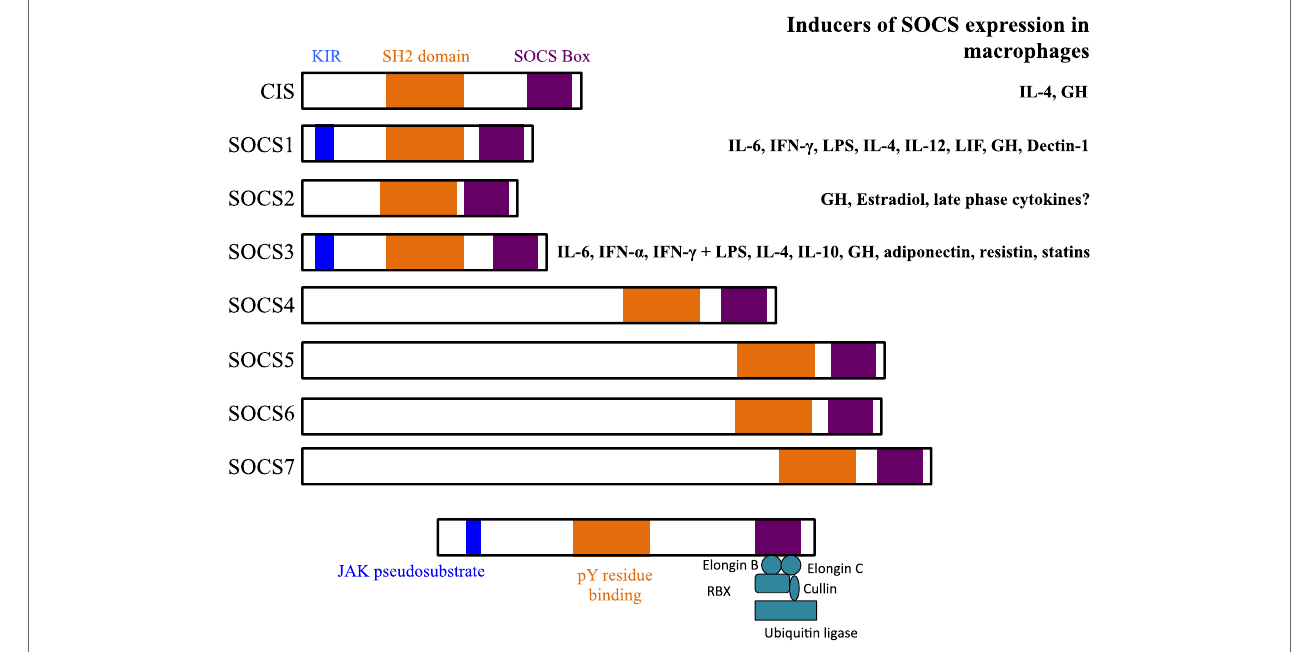
FiGURe 1 | Structures of suppressor of cytokine signaling (SOCS) family members and known inducers in monocytes/macrophages and DCs . The SH2 domain is highly conserved across all SOCS members and binds phosphorylated tyrosine (pY) resides on target proteins. The kinase inhibitory region (KIR) of SOCS1 and SOCS3 acts as a pseudosubstrate to block JAK activation. The KIR inhibits the catalytic activity of JAKs by binding to the activation loop of the catalytic domain through both its KIR and SH2 domains. The SOCS box interacts with a complex containing elongin B, elongin C, cullin-5, RING-box-2 (RBX2), and E2 ligase. SOCS box-containing molecules function as E3 ubiquitin ligases and mediate the degradation of proteins that they associate with through their amino-terminal regions. SOCS proteins target the entire cytokine-receptor complex, including Janus kinase (JAK) proteins and SOCS protein themselves, for proteasomal degradation. GH, growth